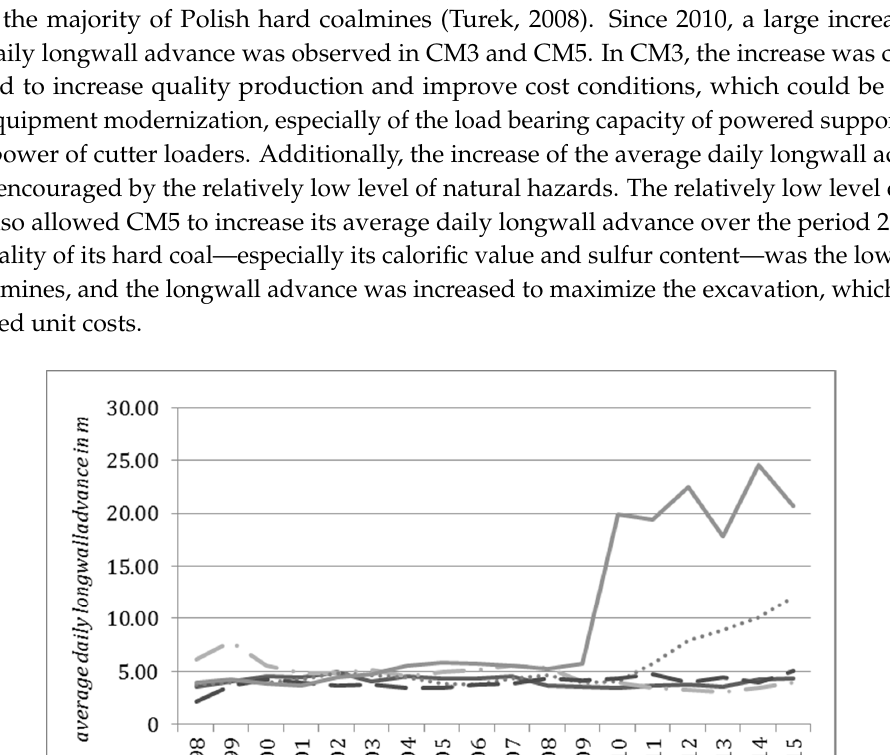
Figure 7. Average length of a longwall in the examined coalmines over the period 1998–2015 (m). Source: own work.